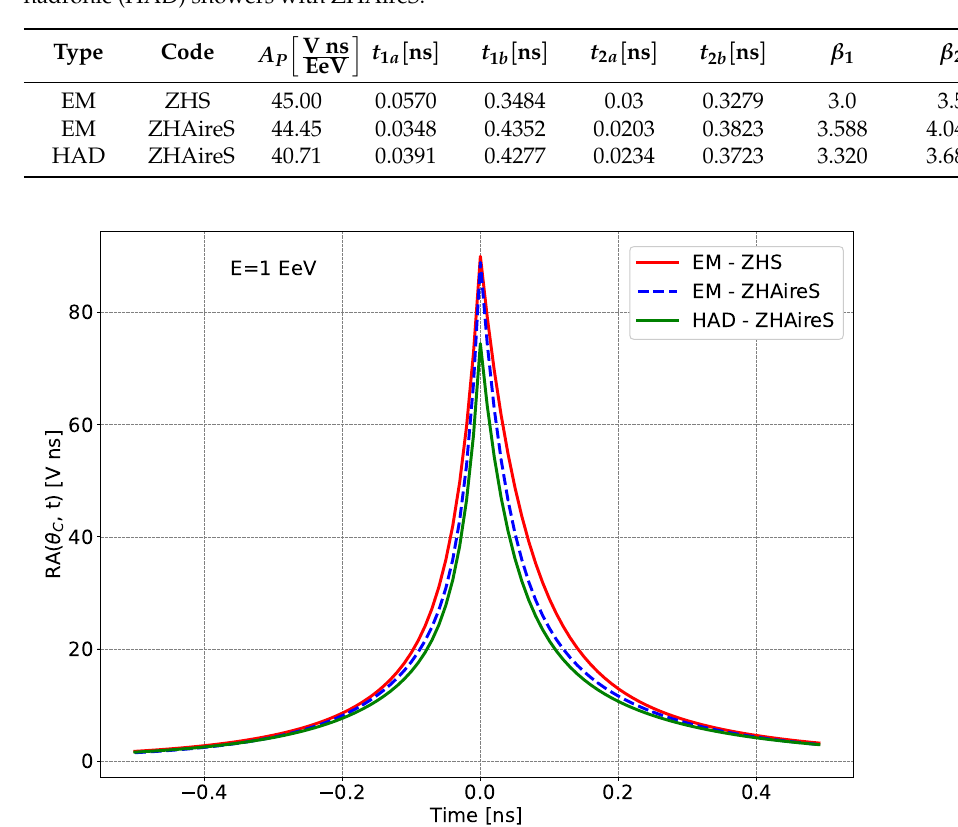
Table 1. Best fit parameters for the vector potential parameterization of Equation (25) as obtained from fits to electromagnetic (EM) simulations made in ice both with ZHS and ZHAireS as well as for hadronic (HAD) showers with ZHAireS.